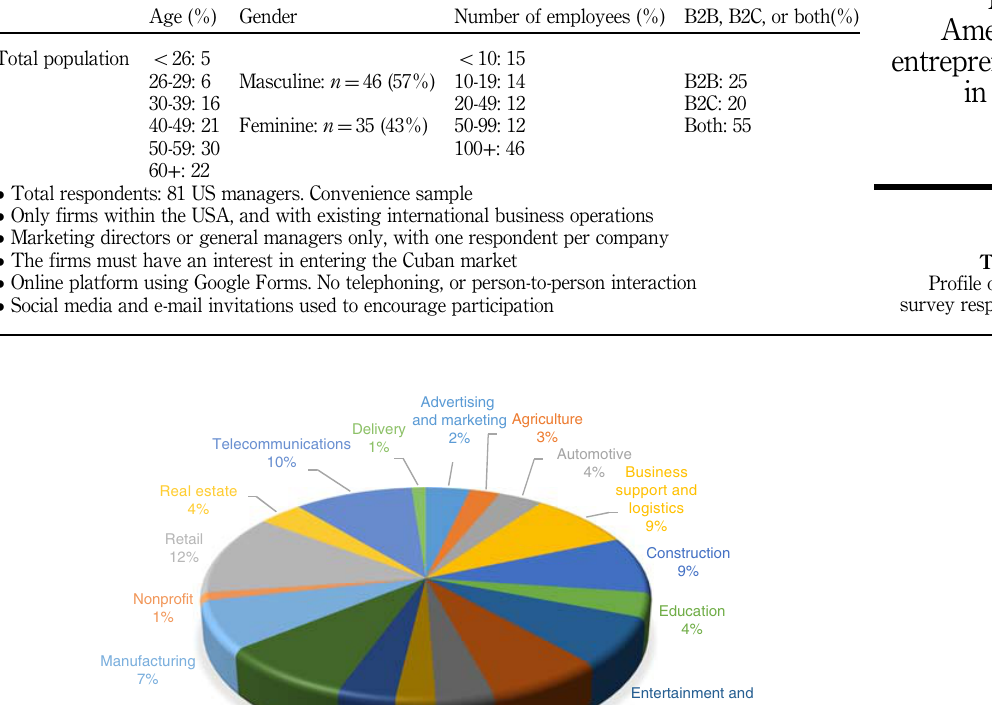
Figure 1. Summary of industry sectors represented by the total